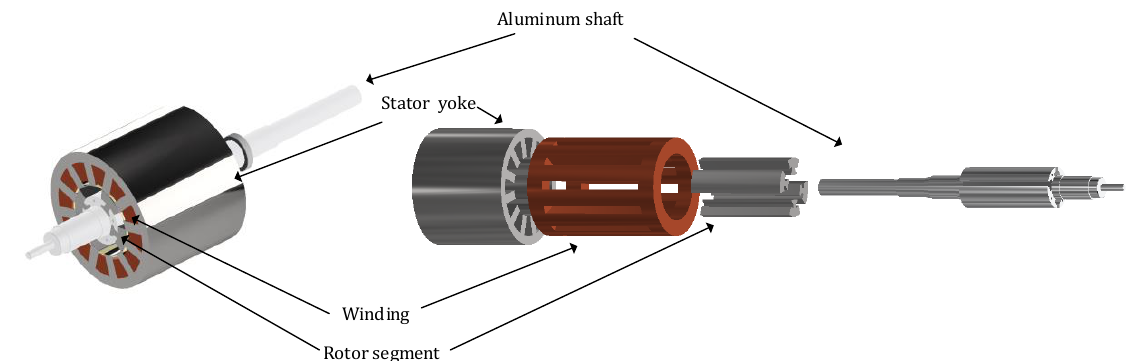
Figure 6. CAD model of the stator and rotor of the proposed SRM.